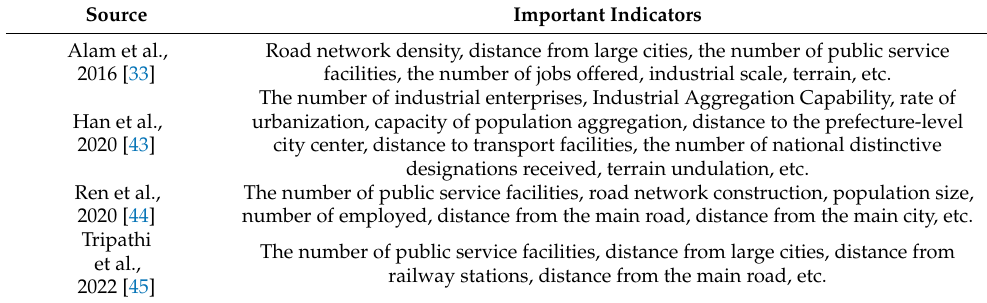
Table 1. Relevant indicators from existing